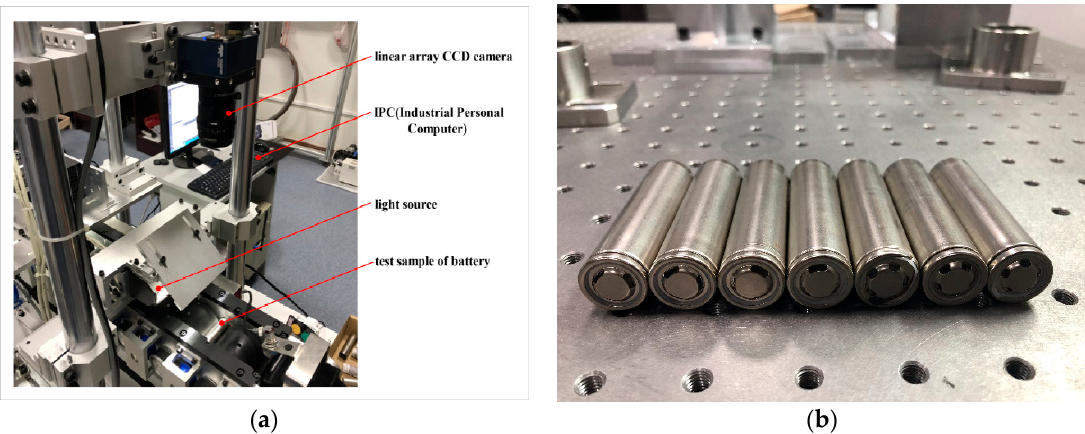
Figure 2. System structure. ( a ) Detection system; ( b ) Test samples of battery.